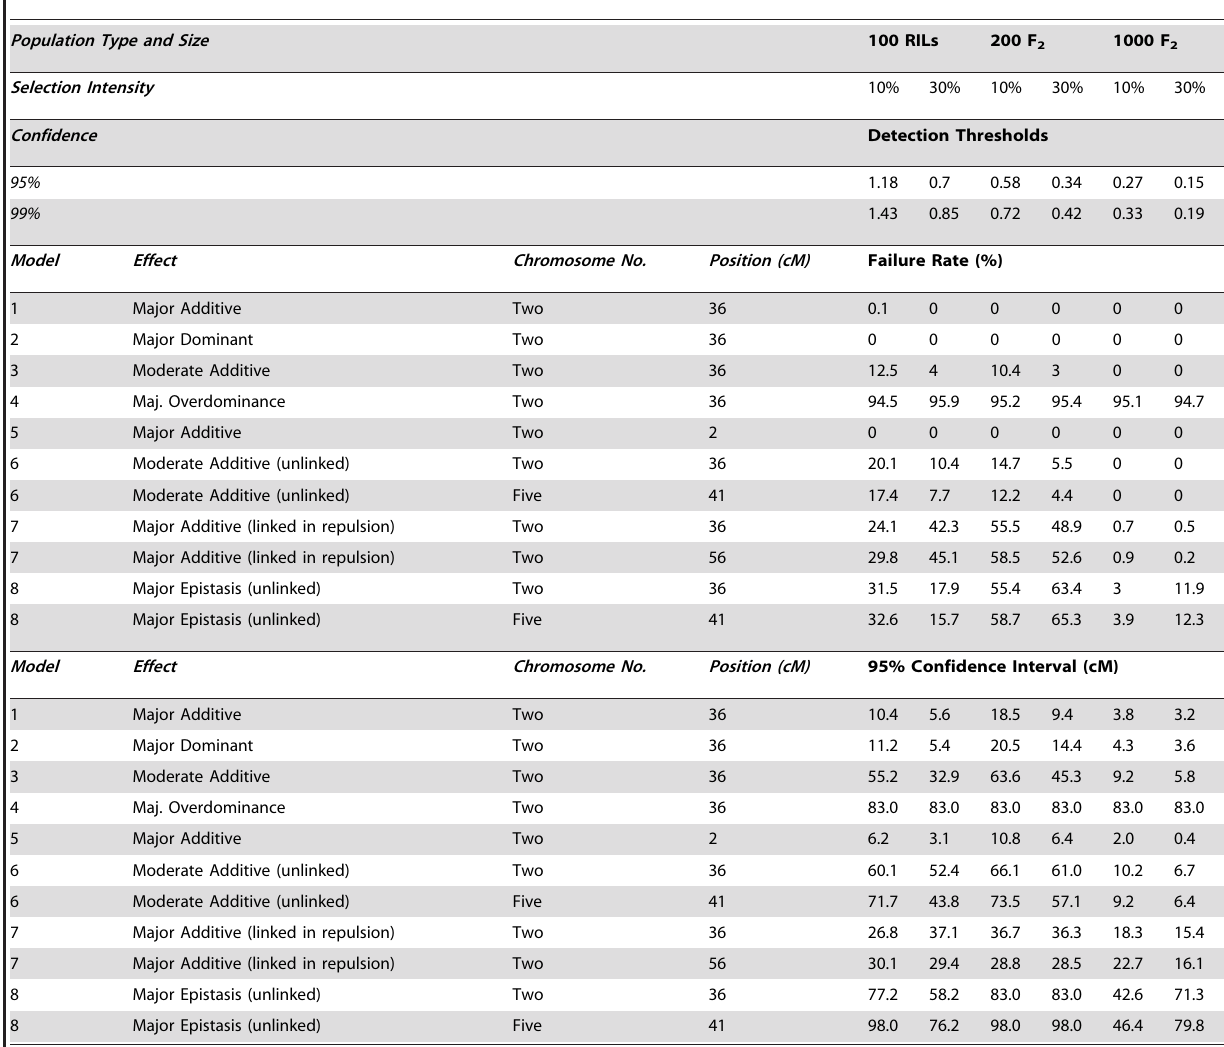
(Top) The horizontal detection thresholds calculated by considering the minimum signal not exceeded by the unlinked chromosomes in 95 and 99% of the simulations. (Middle) The rate of failure, as a percentage, for a linked chromosome to exceed the 95% threshold for detection constructed from the maximum and minimum values on unlinked chromosomes. (Bottom) The 95% confidence intervals constructed representing the central width of the chromosome that contained the peak in 950 of 1000 simulations. These data represent the precision of the mapping technique for each model, population, and selection